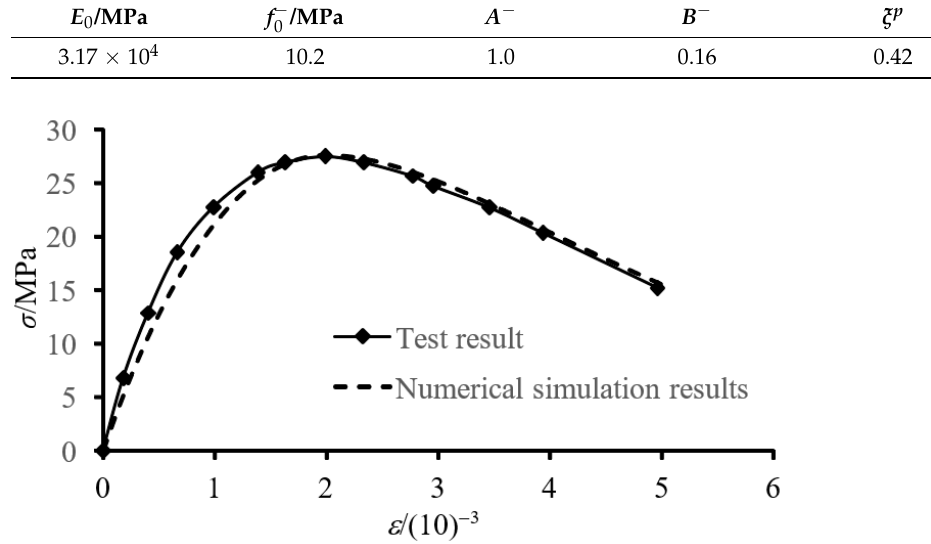
Figure 2. Comparison of numerical simulation result and experimental result (uniaxial compres- sion test). Table 2. Simulation parameters of uniaxial compression test.